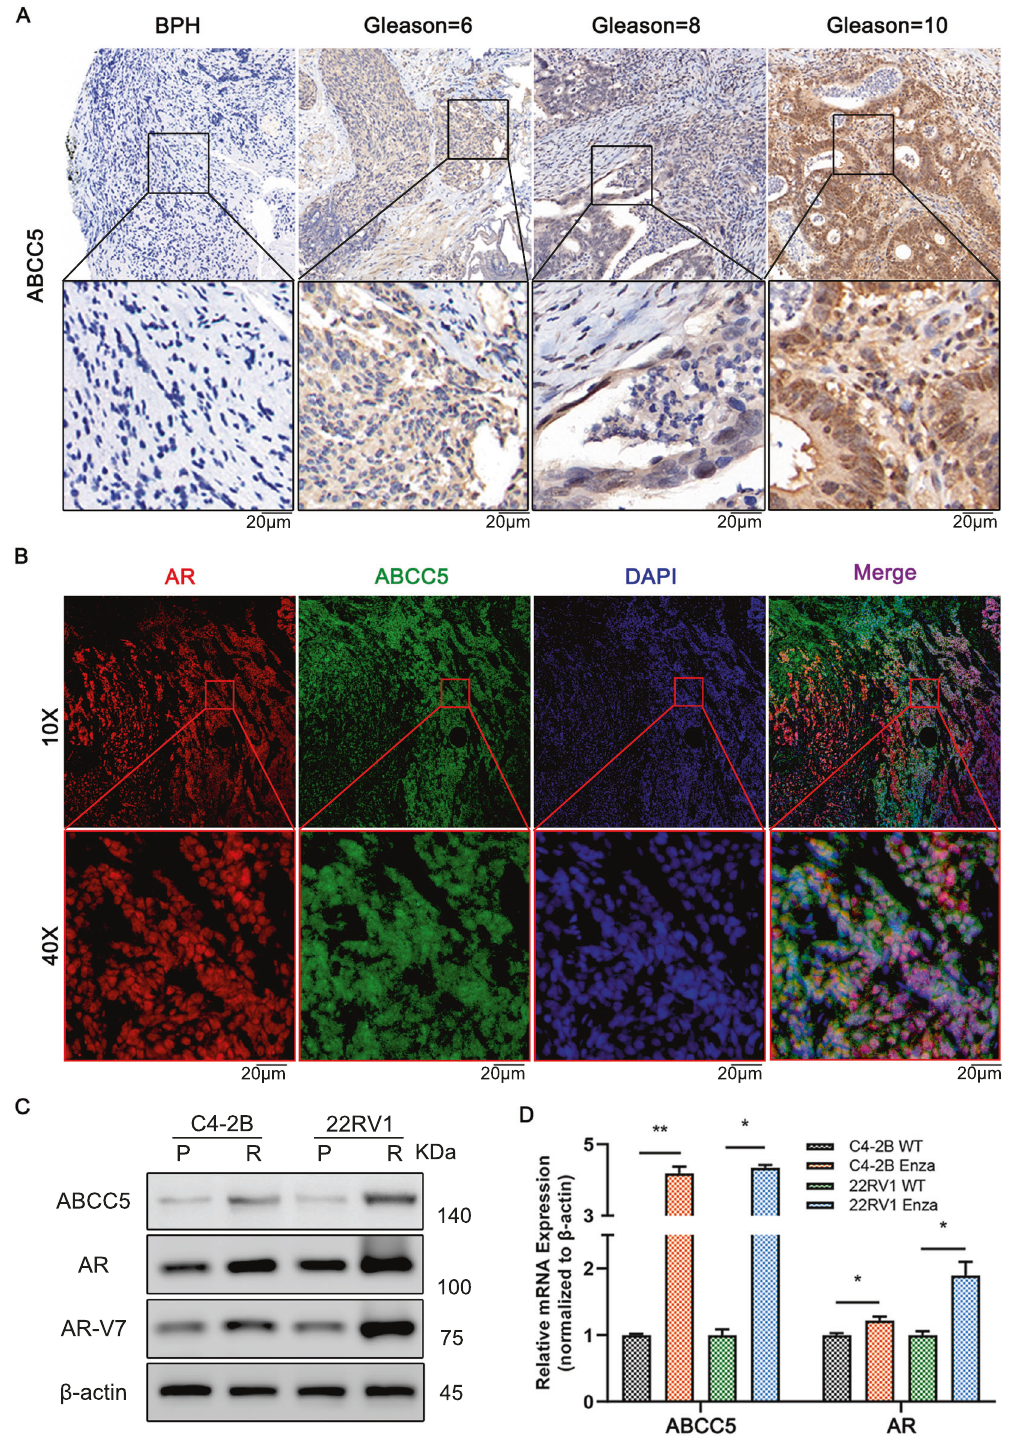
Fig. 2 ABCC5 expression in prostate cancer patients. A Representative tissue staining images of ABCC5 expression in BPH and tumor tissues with several Gleason scores. Scale bars, 20 μ m. B Immuno fl uorescence images of AR and ABCC5 localization in CRPC tissue. Scale bars, 20 μ m. C PCa cells were subjected to the levels of selected proteins. D mRNA levels of AR and ABCC5 were measured by qRT-PCR. * P < 0.05, ** P < 0.01, *** P < 0.001, **** P < 0.0001. P, parental cell; R, enzalutamide-resistant cell.